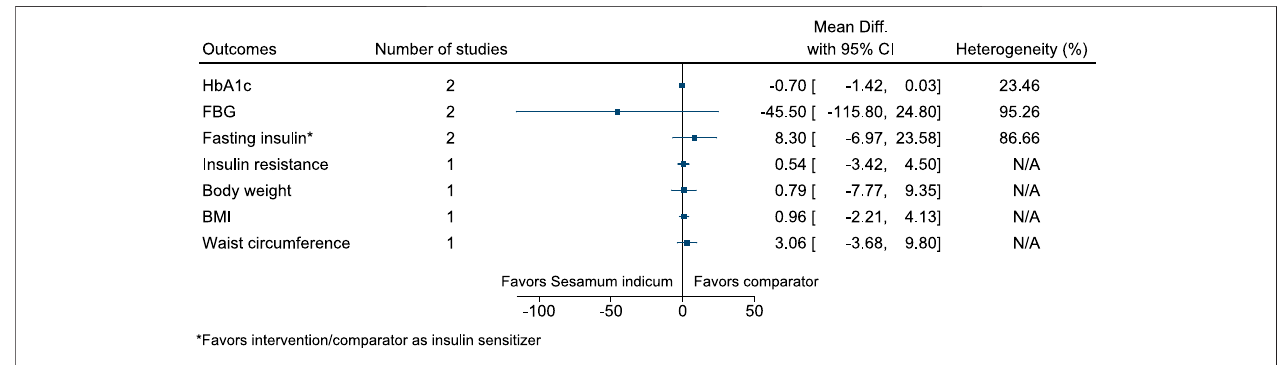
FIGURE 29 | Sesamum indicum — Summary forest plot.